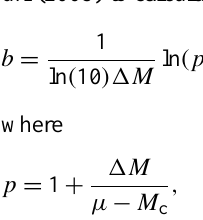
Mainshock Magnitude Swarm duration Number of